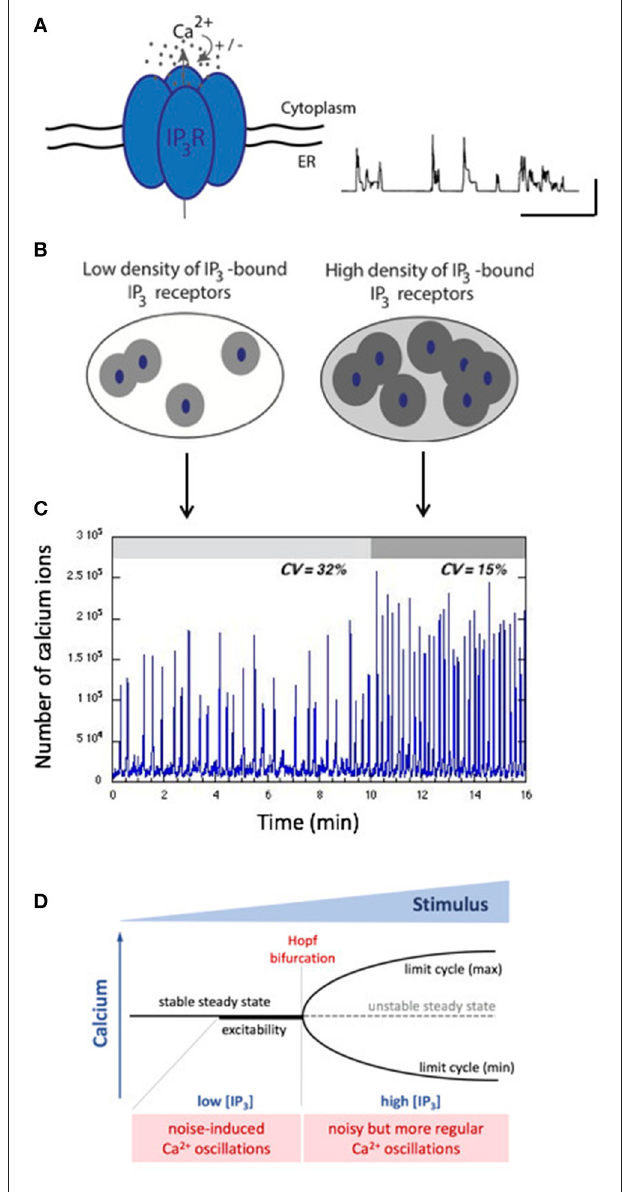
FIGURE 3 | Stochastic vs. deterministic character of intracellular Ca 2 + dynamics. (A) The IP 3 R that opens upon IP 3 binding and is biphasically regulated by Ca 2 + is the building block of intracellular Ca 2 + dynamics. When isolated or clustered in small numbers, IP 3 R open randomly in a repetitive manner leading to localized, highly variables Ca 2 + signals called “puffs.” The trace shows stochastic simulations of such Ca 2 + puffs obtained as in Swillens et al. (1999). The horizontal and vertical bars represent 1s and 100nM, respectively. (B) Depending on the level of IP 3 , different numbers of IP 3 R participate to the cellular Ca 2 + dynamics. When IP 3 is low, few IP 3 R participate (left) while at high concentration of IP 3 , many channels participate, which increases the spatial coupling through cytosolic Ca 2 + (right). (C) Gillespie’s simulations indicate that two situations generate qualitatively different Ca 2 + dynamics. For sub-threshold IP 3 concentrations, noisy spiking (with a high coefficient of variation) arises. A small increase in IP 3 concentration allows the passage of a threshold, in which case spiking corresponds tolimit-cycleoscillationsperturbedbynoise.SeeDupontetal.(2008)fordetails. (Continued)